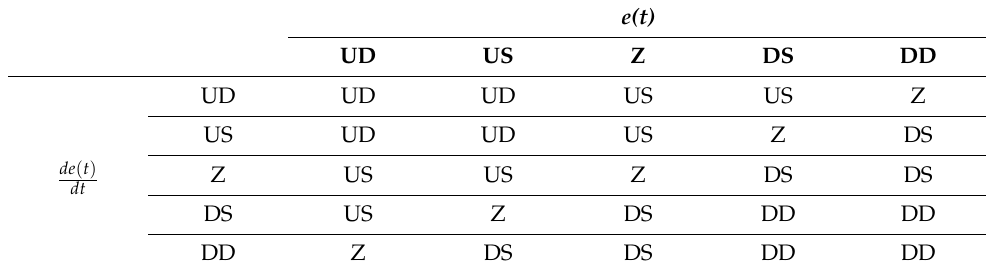
Figure 14. Membership functions: ( a ) error; ( b ) derivative of error; and ( c ) output. Table 1. Base rule of the fuzzy logic controller.